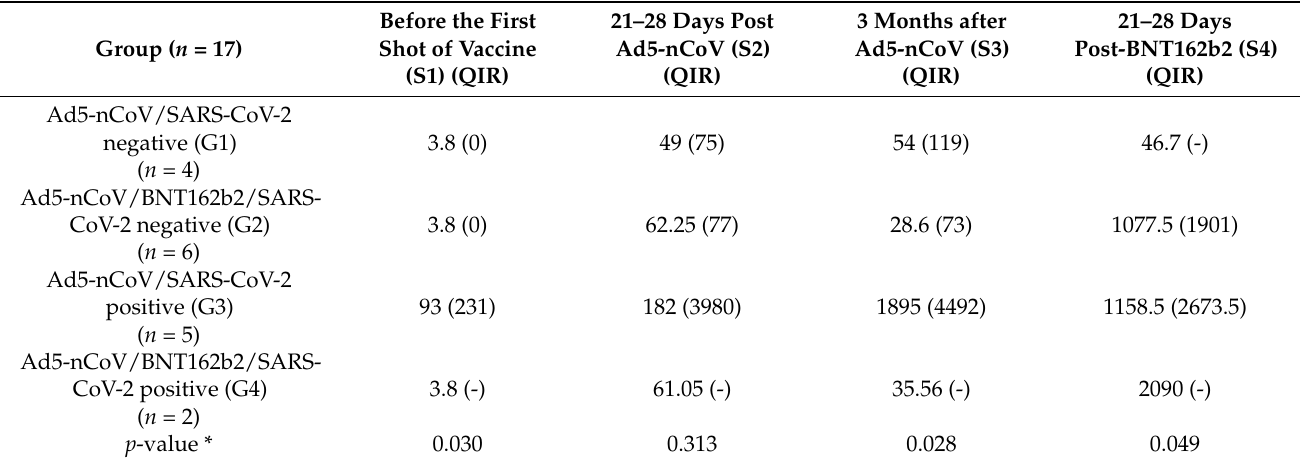
Table 2. Quantitative SARS-CoV-2 spike 1-2 IgG antibody titers against SARS-CoV-2 in the different groups of participants depending on the applied vaccines and SARS-CoV-2 history.